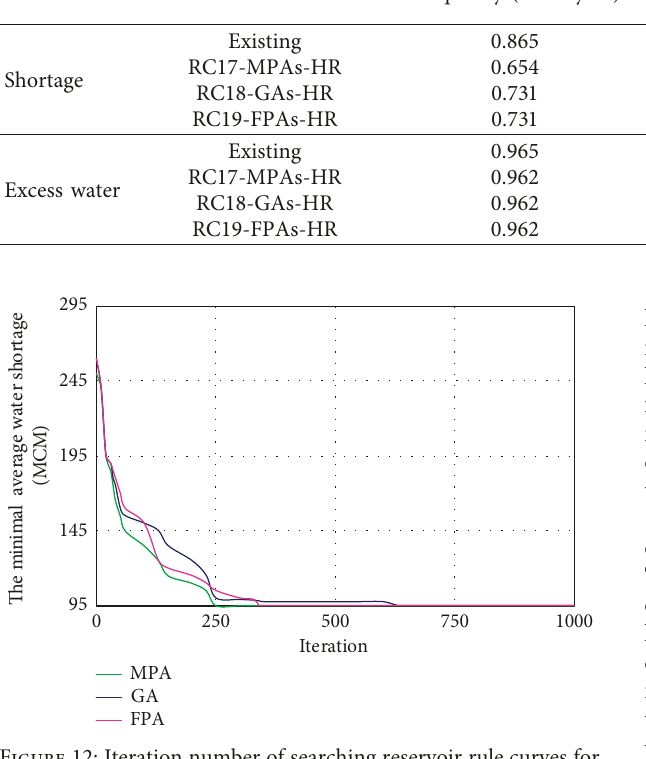
Figure 12: Iteration number of searching reservoir rule curves for MPA, GA, and FPA